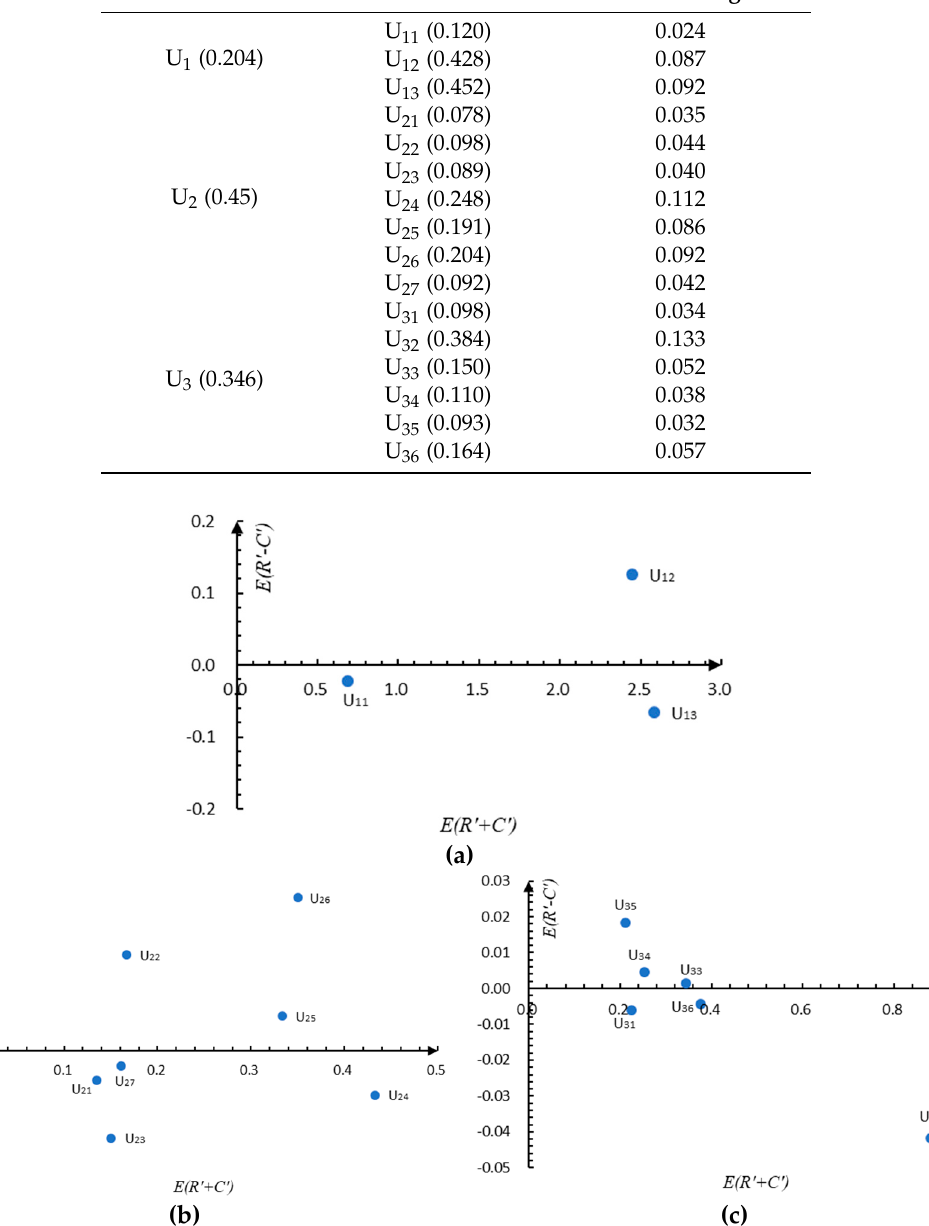
. Table 18. The ranking of alternatives for inland NPPs. ∗ i d